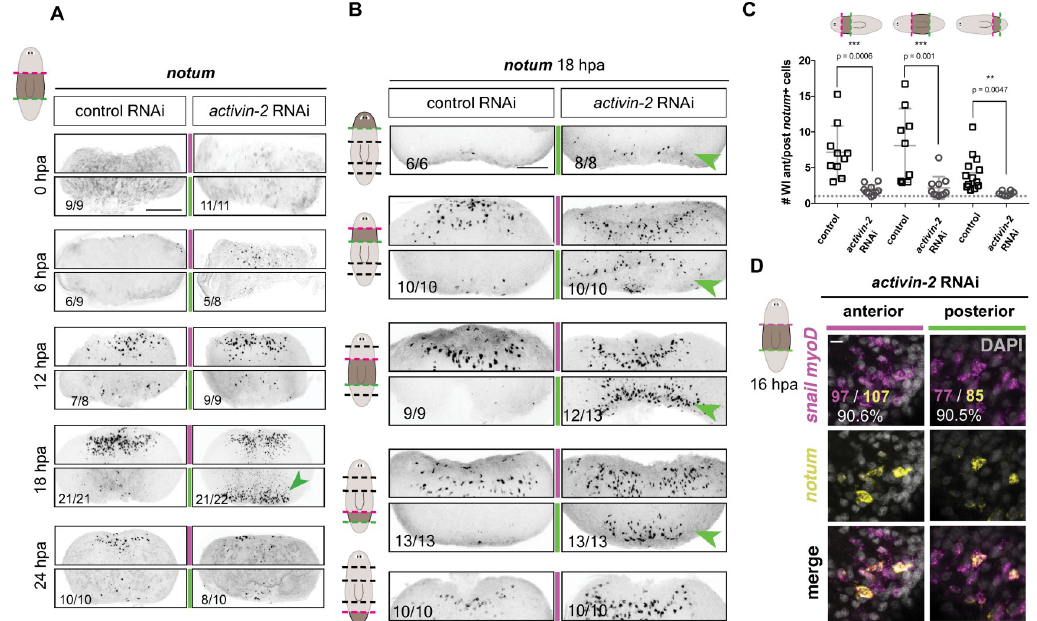
Fig 4. activin-2 promotes the polarized response of longitudinal muscle fibers to wound orientation independent of AP- axis position. (A) Increased notum is seen at posterior-facing wounds specifically at 18 hours post amputation. (B) FISH shows increased notum expression at posterior-facing wounds across the AP axis. Animals were amputated into five fragments and assayed at 18 hours post amputation. (C) Graph shows quantification for (B). Data are shown as the ratio of notum + cells found at anterior-facing versus posterior-facing wounds of a given piece. Kruskal-Wallis (one-way ANOVA on ranks) test with multiple comparisons was performed to determine P values. (D) FISH shows co-expression of wound-induced notum and myoD , snail at anterior- and posterior-facing wounds in activin-2 RNAi animals. Number of myoD/snail+ cells that co-localize with notum (magenta) out of total notum + cells (yellow). White number, percentage of notum+ cells that are longitudinal fibers. All images are anterior up. Scale bars, 200 μ m, except for high magnification panels in where they represent 10 μ m.